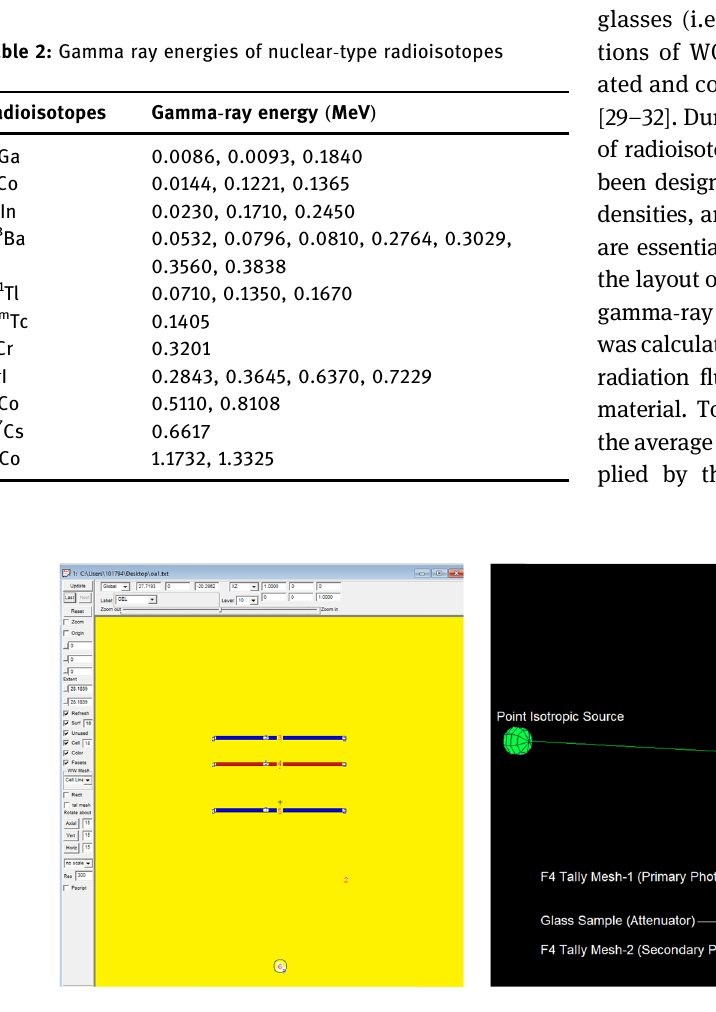
Figure 1: 2 - D and 3 - D illustration of designed MCNPX setup ( 2 - D and 3 - D views are obtained from MCNPX Visual Editor VisedX22S )